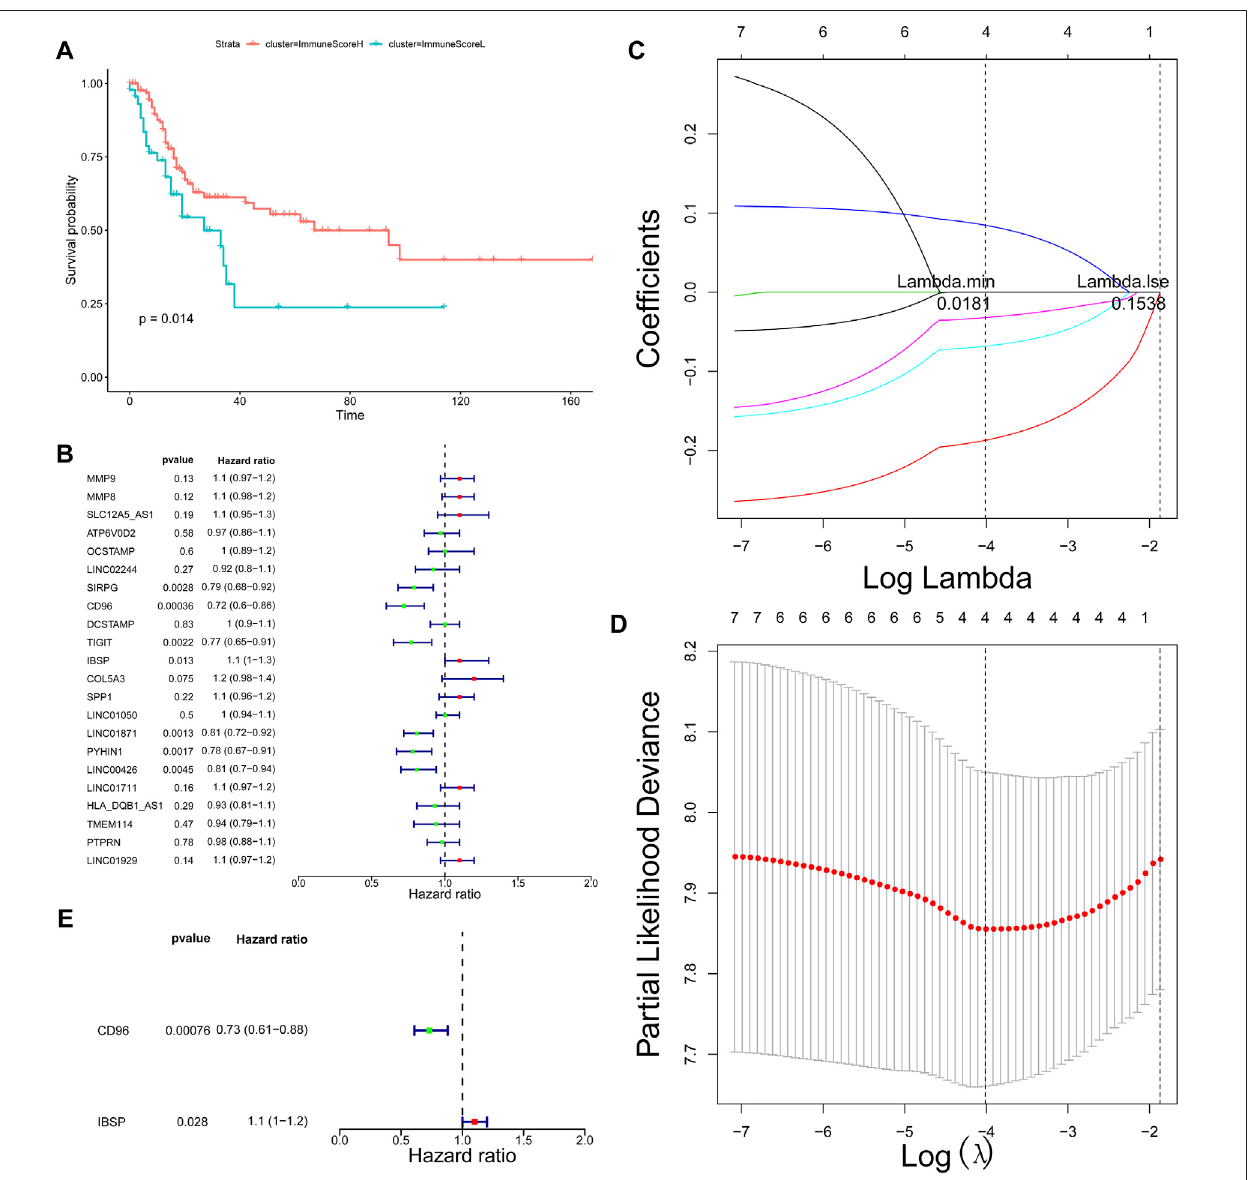
FIGURE2| Screeningofprognosticmarkers. (A) SurvivalanalysisofpatientsindifferentImmuneScoreclusters. (B) UnivariateCoxregressionanalysisshowingthe HRofeachDEGinpredictingOSinBLCA. (C) LASSOcoef fi cientpro fi lesofthe7DEGs. (D) Tenfoldcross-validationfortuningparameterselectionintheLASSOmodel. The red dots indicate the partial likelihood deviance values, the gray lines indicate the standard error (SE) values, and the two vertical dotted lines on the left and right indicate the optimal values determined by the minimum criteria and 1-SE criteria, respectively. “ Lambda ” is the tuning parameter. (E) Multivariate Cox analysis identi fi ed the optimal variables for constructing the prognostic signature in BLCA; p < 0.05.